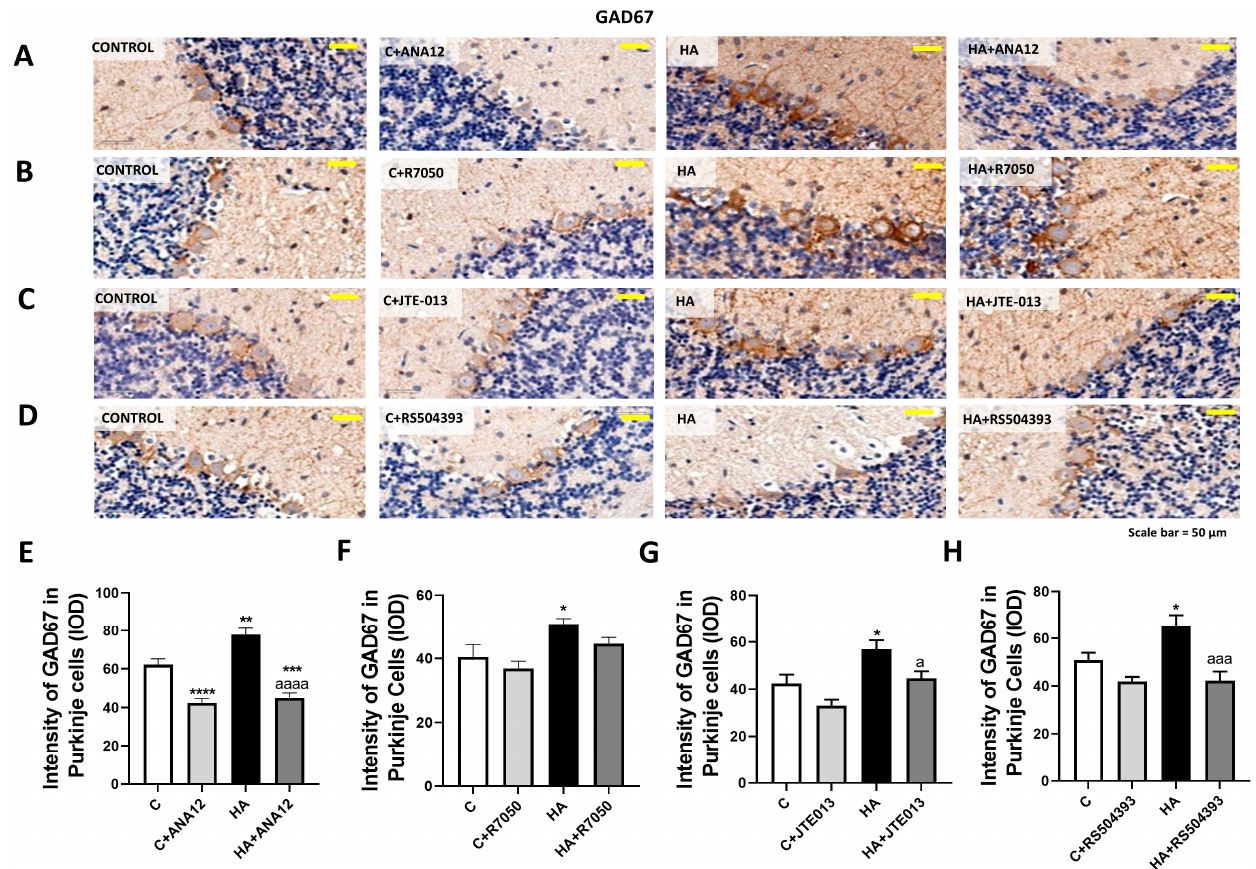
Figure 3. GAD67 content increased in the Purkinje neurons of hyperammonemic rats. Ex vivo treatment with ANA12, R7050, JTE-013, or RS504393 reversed this increase. ( A – D ) Immunohistochemistry was performed as indicated in Section 4, with DAB staining using antibodies against GAD67. Representative images are shown. ( E – H ) GAD67 content was quantified in Purkinje cells as described in Section 4. Values are the mean ± SEM of 8 rats per group. Values significantly different from control rats are indicated with asterisks, and from hyperammonemic rats are indicated with “a”. * p < 0.05, ** p < 0.01, *** p < 0.001, **** p < 0.0001; a p < 0.05, aaa p < 0.001, aaaa p < 0.0001. ( E – H ) F values were 35.26, 5.622, 9.090, and 8.133, -respectively. Data were analyzed using one-way analysis of variance (ANOVA) followed by Tukey’s post hoc